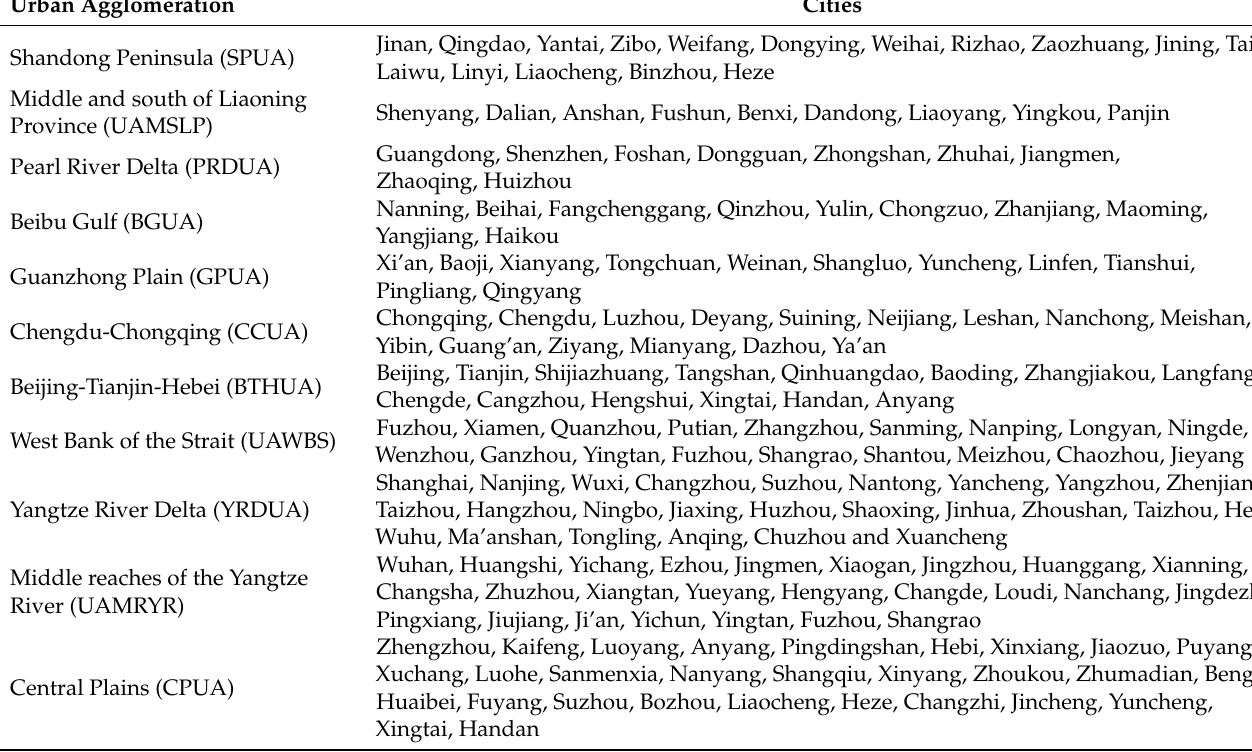
Table 1. The selected cities of 11 urban agglomerations in